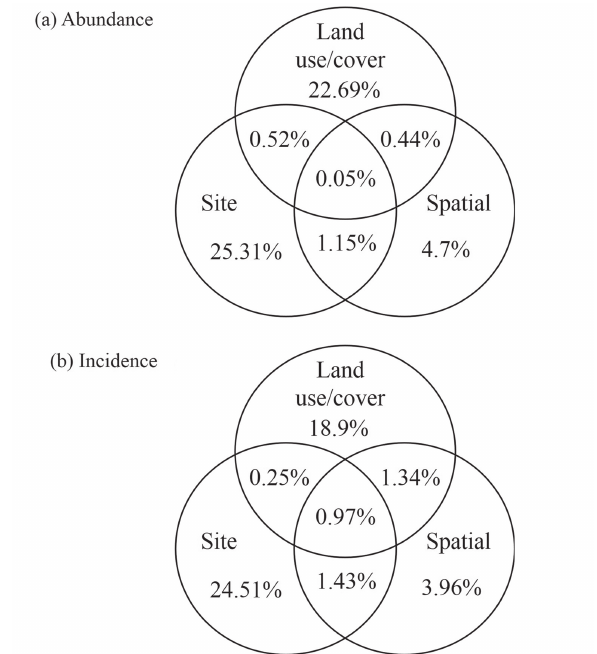
Fig. 3. Venn diagrams representing the results of the variance partitioning with partial CCA (canonical correspondence analysis): percentage of variation in fish abundance (a) and incidence (b) explained by land use and land cover, site, and spatial variables, as well as that shared between the three sets of variables in the Upper Araguari River basin, Minas Gerais. See Table 4 for a list of all explanatory